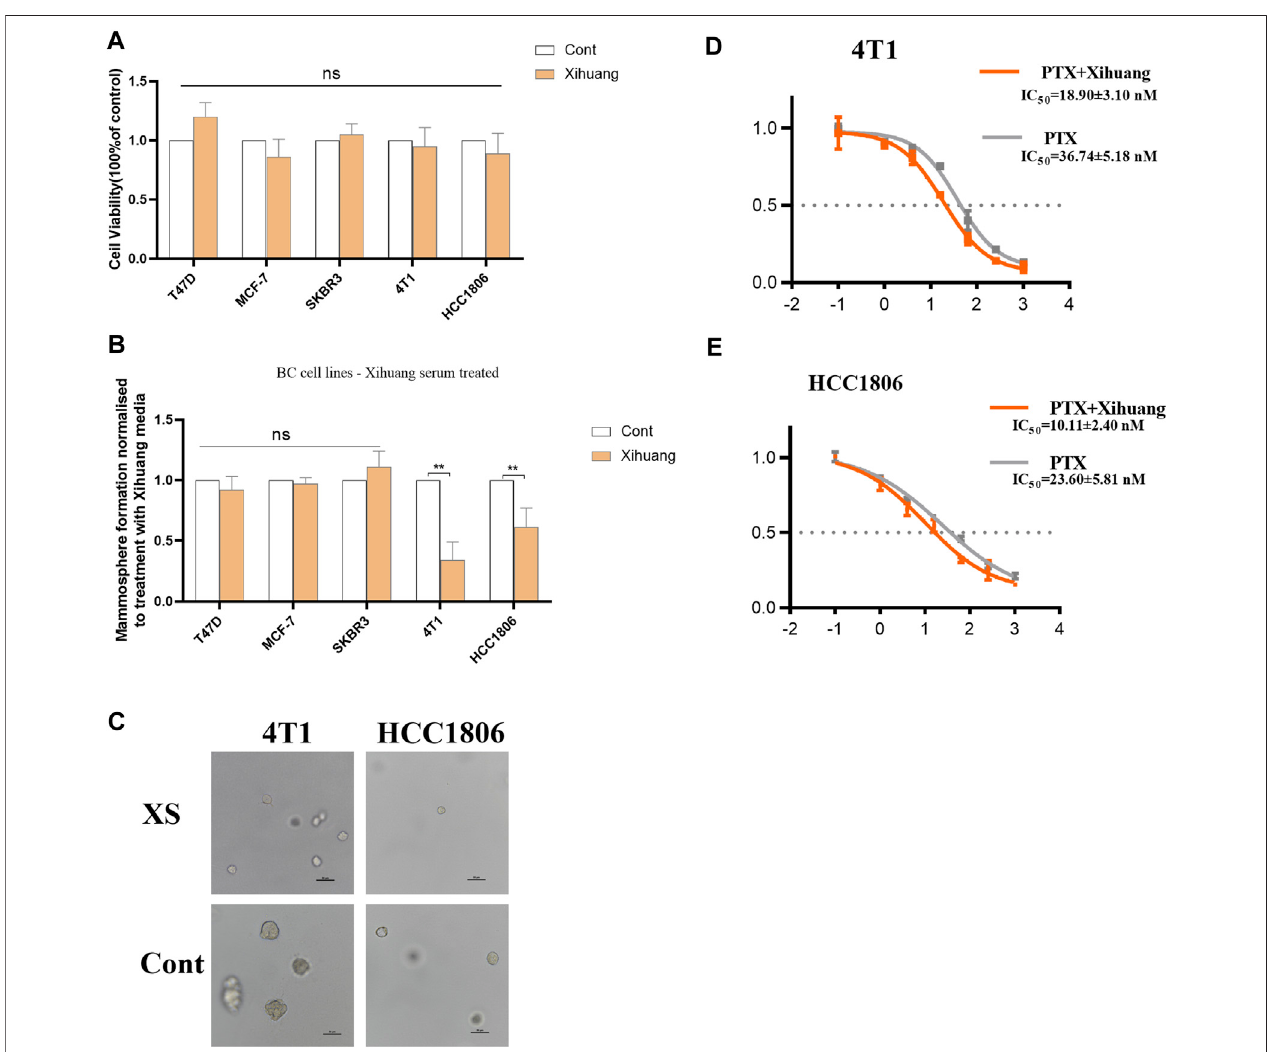
FIGURE 2 | Effect of serum containing Xihuang pills (XS) on stem cell colony formation of TNBC cells. (A) MTT analysis indicated that the proliferation of breast cell wasnotinhibitedbyXStreatment in48 h. (B) XSincreasedmammospherecolonyformationinTNBCcelllines (4T1and HCC1806) compared tocontrolserum (CONT). (C) Representative photomicrographsof mammospheres formed by4T1 and HCC1806 cells treated with serum containing Xihuang pills and controlserum (CONT) are shown. Scale bar 50 µM. (D,E) 4T1 and HCC1806 cells were treated with 0, 0.1, 1, 4, 16, 64,256, or 1024 nM PTX for 48 h. MTT assay was used to detect the viability of cells (XS compared to CONT). * p < 0.05, ** p < 0.01, *** p < 0.001 vs the control group.